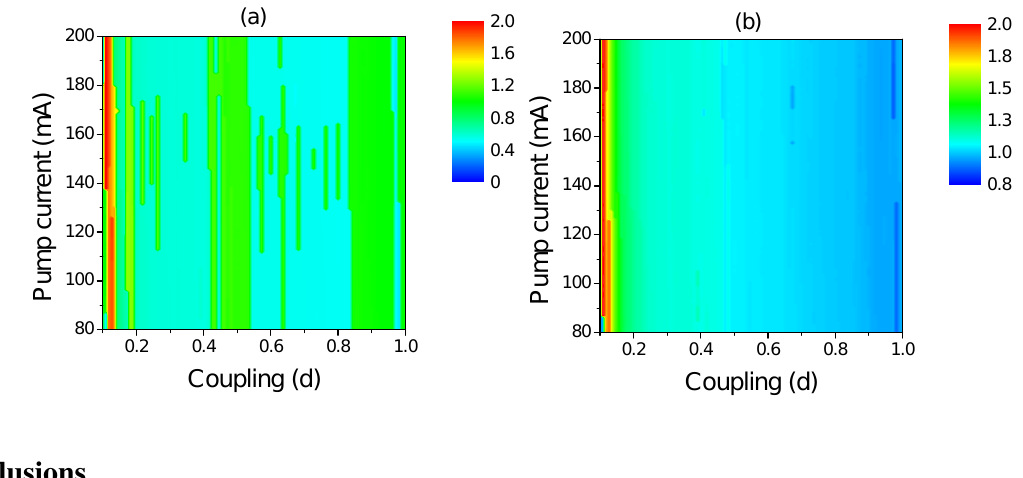
Figure 8. Frequency diagrams of the post-synaptic neuron in the space of coupling strength and laser pump current. The color indicates the ratio between the main oscillation frequency of ( a ) post-synaptic neuron spikes and laser pulses and ( b ) post-synaptic and pre-synaptic neuron spikes. The regions of different dynamical regimes correspond to different winding numbers p : q